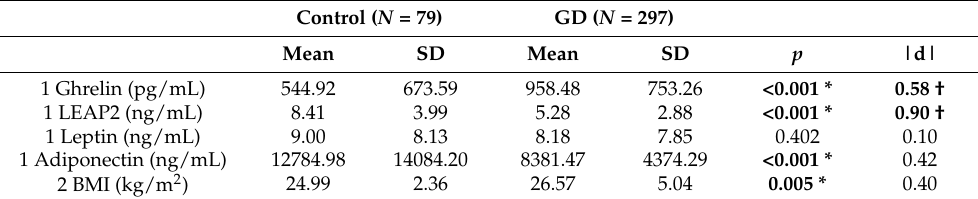
Table 1. Comparison of clinical characteristics via